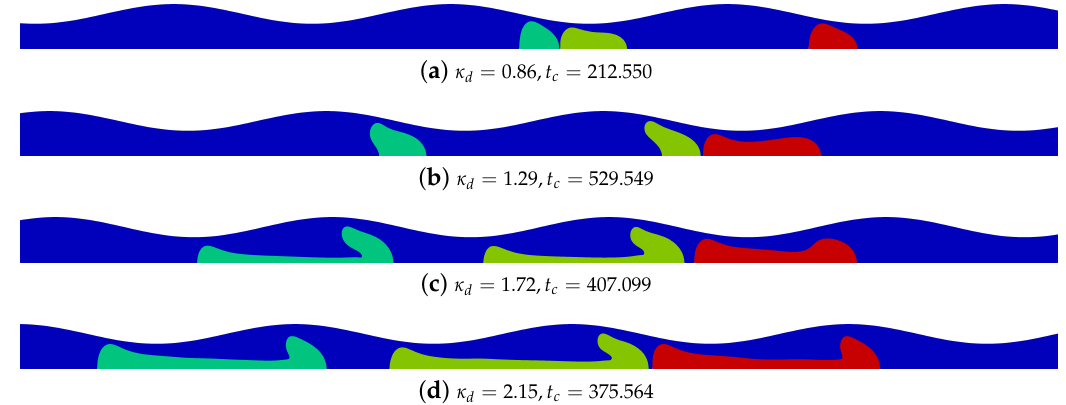
Figure 15. Parametric study of coalescence time t c between drops in slug flow for the sinusoidal channel with amplitude A = 0.14, initial slug length s = 1.375 and several drop’s size factor κ d = 0.86,1.29,1.72,2.15. In subfigure ( a ), the rear and the center drops coalesce, where for the others the coalescence takes place between the center and front drops. All parameters are